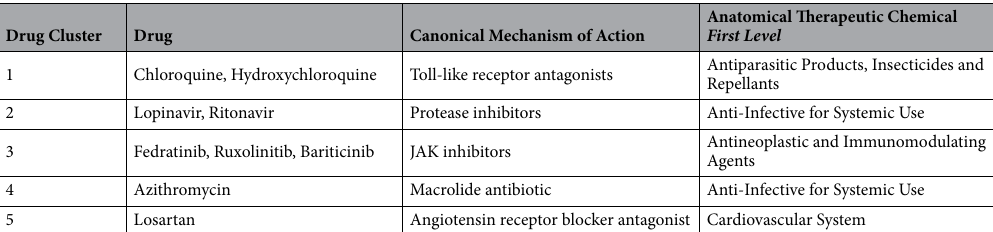
Table 1. Drug target groupings. Drug targets with iLINCS signatures that are in use or under investigation for the treatment of COVID-19 were grouped together if they met a least two of the three following criteria: Canonical Mechanism of Action, referenced from the database DrugBank (https ://www.drugb ank.ca/); Anatomic Therapeutic Chemical classification, referenced from https ://www.whocc .no/atc_ddd_index